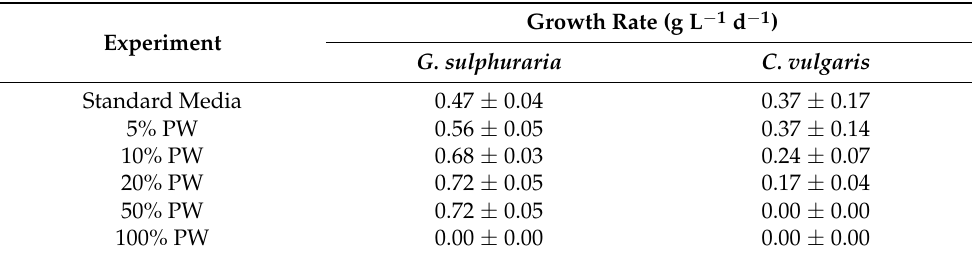
Figure 1. Growth curve for ( a ) Galdieria sulphuraria ; ( b ) Chlorella vulgaris . Data points represent the average ± SD of n = 6 biological replicates. Table 3. Growth rates of G. sulphuraria and C. vulgaris . Values represent the average ± SD of n = 6 biological replicates.